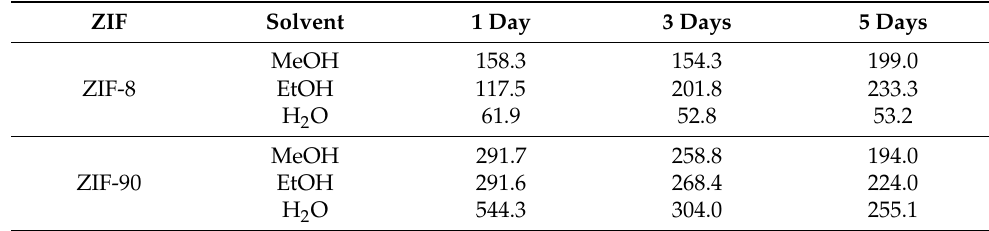
Table 5. Desorption enthalpy (J/g) for ZIF-8 and ZIF-90 after soaking for 1 day, 3 days and 5 days. ZIF Solvent 1